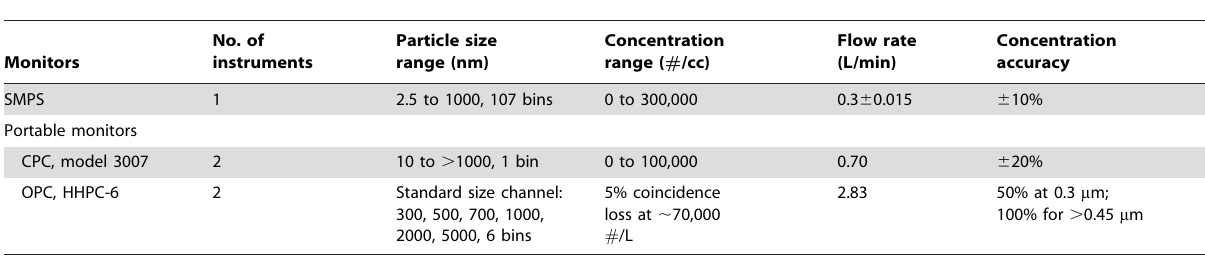
Table 1. Specifications of the real-time particle monitors assessed in this study.